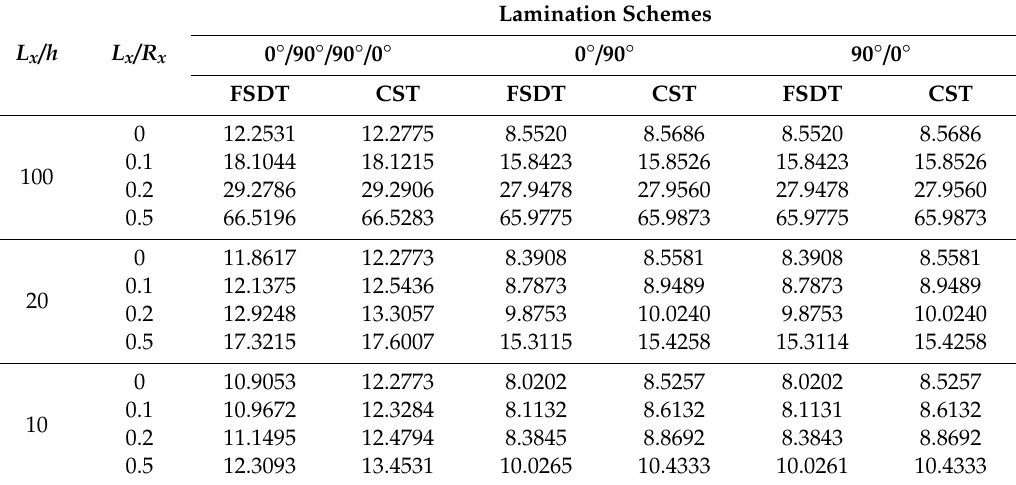
Table 8. The fundamental frequency parameter Ω for three types of layered composite shallow spherical shells for variety theories, length to thickness ratios L x / h , and length to radius ratios L x / R x with the SD-SD boundary condition.